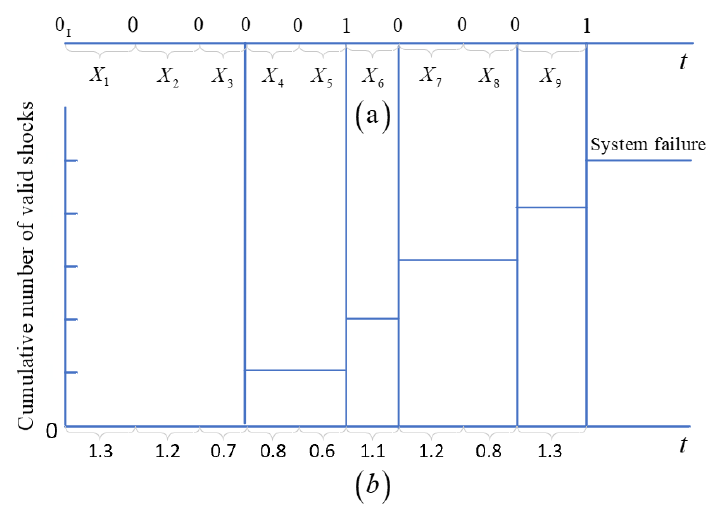
Figure 1. Failure process of the system under self-exciting trigger mechanism 1. (a denotes the type of shock and b denotes the shock occurrence time).